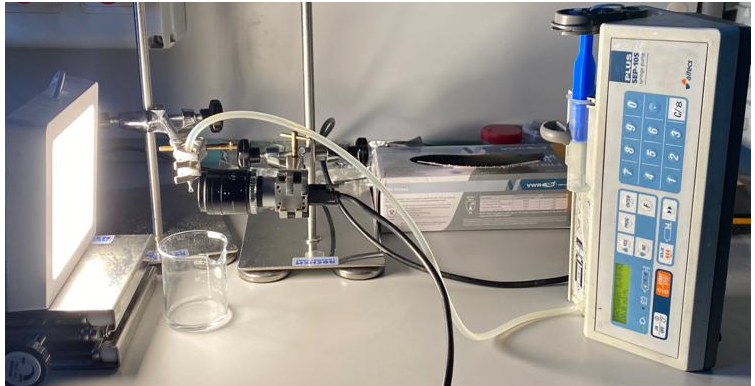
Figure 1. Experimental